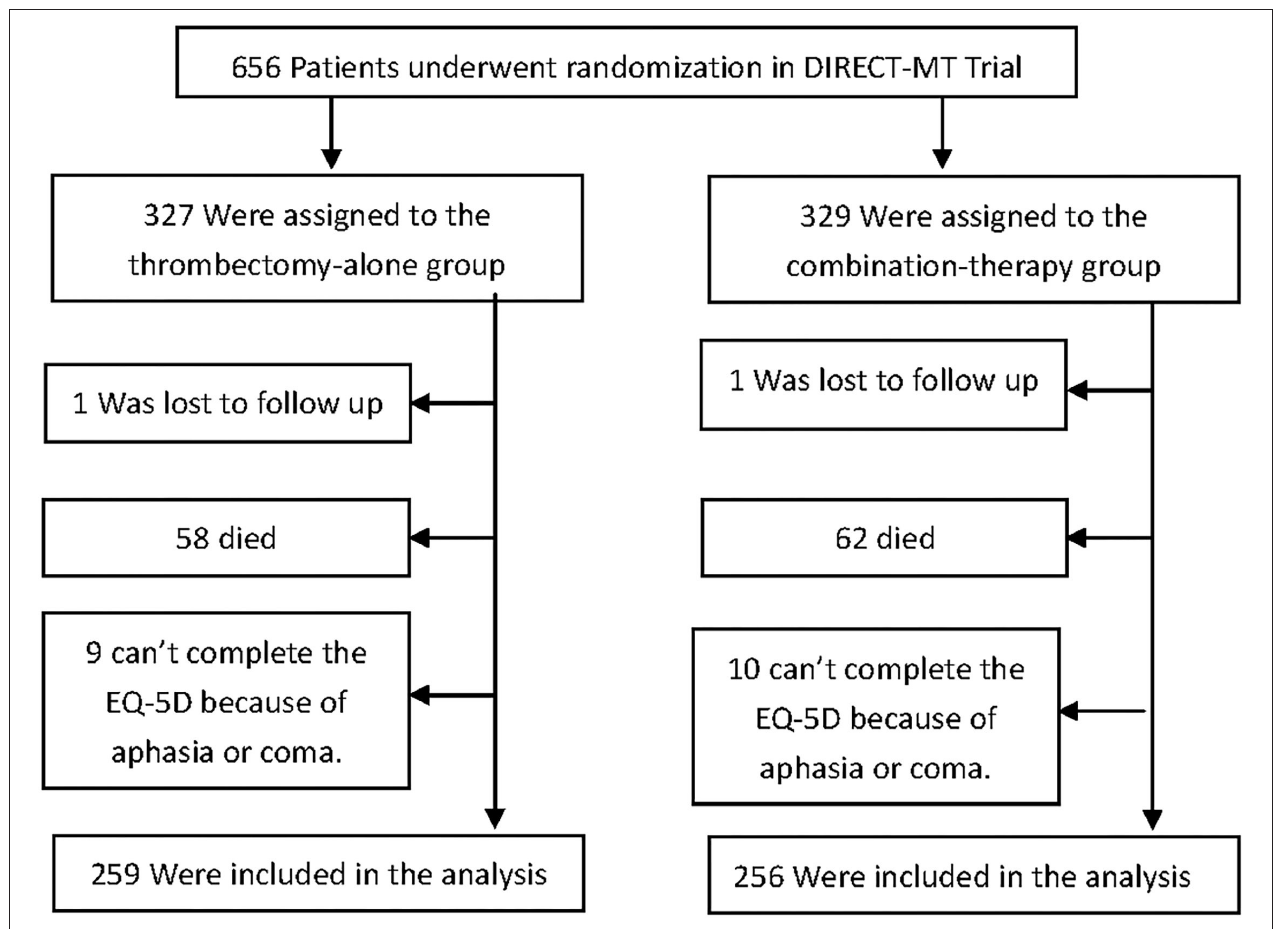
FIGURE 1 | Randomization and treatment of the patients. 656 patients were randomly assigned in a 1:1 ratio to undergo endovascular thrombectomy (thrombectomy-alone group) or to receive intravenous (IV) alteplase followed by endovascular thrombectomy (combination-therapy group) in Direct-MT trial. Excluding the patients who lost follow up, died, aphasia and coma, a total of 515 patients were included in the